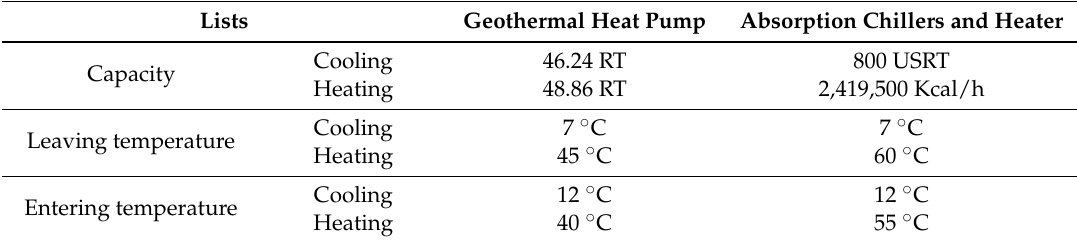
Table 6. Individual room set points.